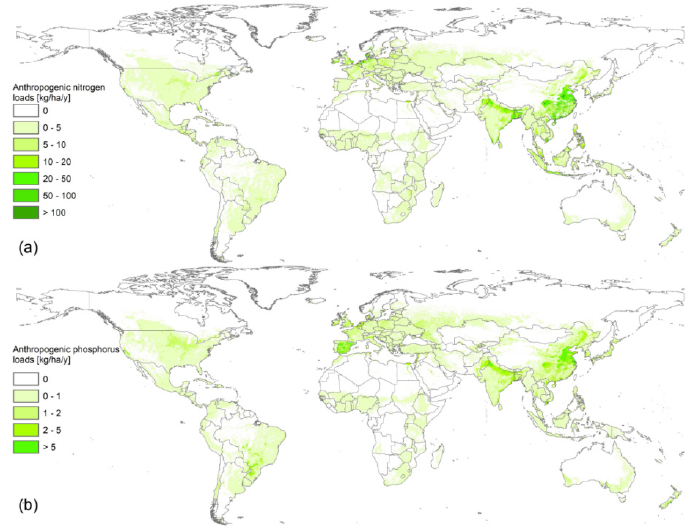
Figure 1. Map of global anthropogenic loads of ( a ) nitrogen and ( b ) phosphorus due to global production of crops shown in kg/ha on a 5 by 5 arc-min grid. Period: 2007. Table 1. Anthropogenic nitrogen and phosphorus emissions to water for selected European countries and EU-27 total.